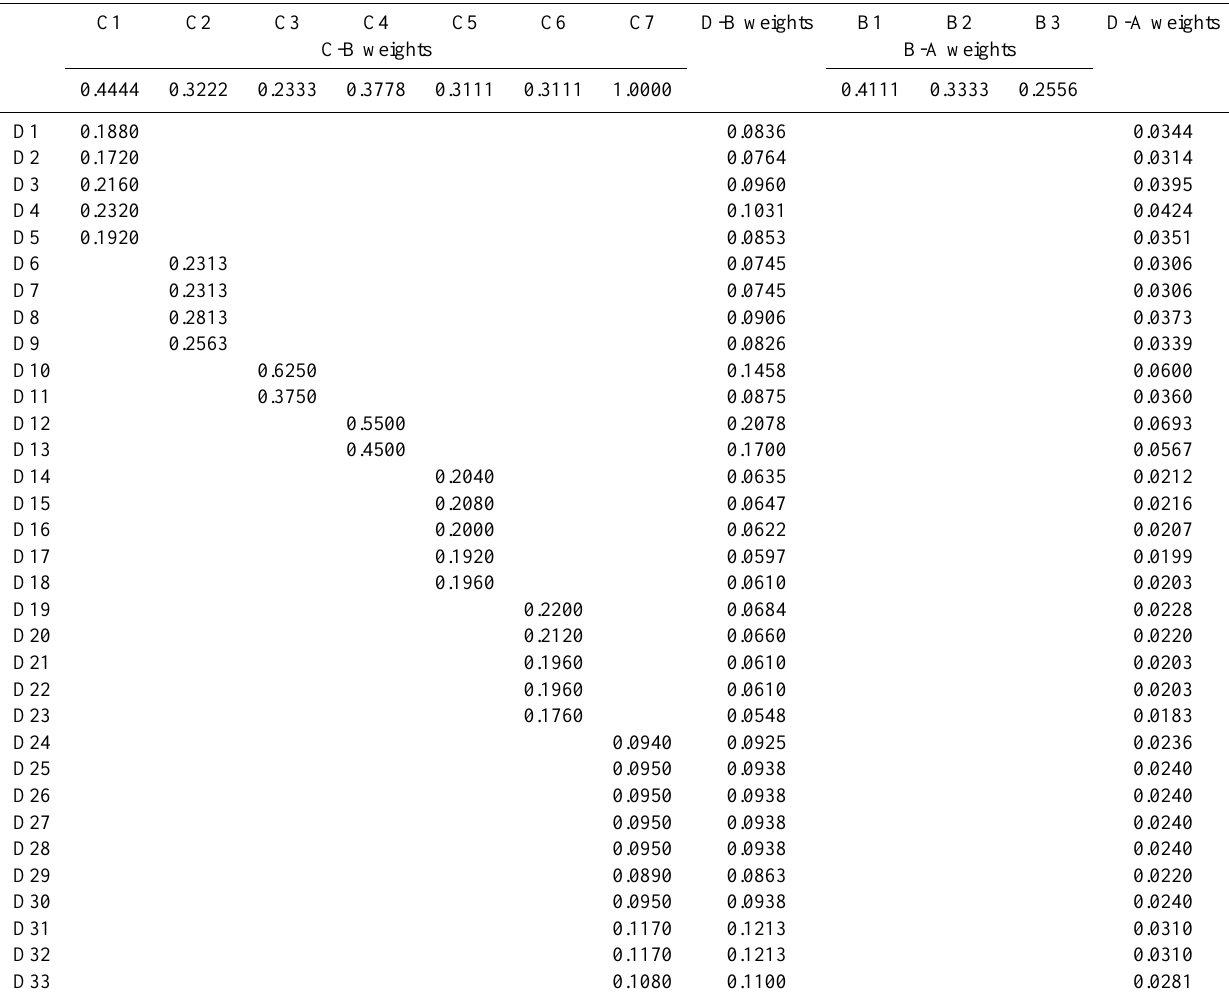
Table 3. Weights of water resources security evaluation